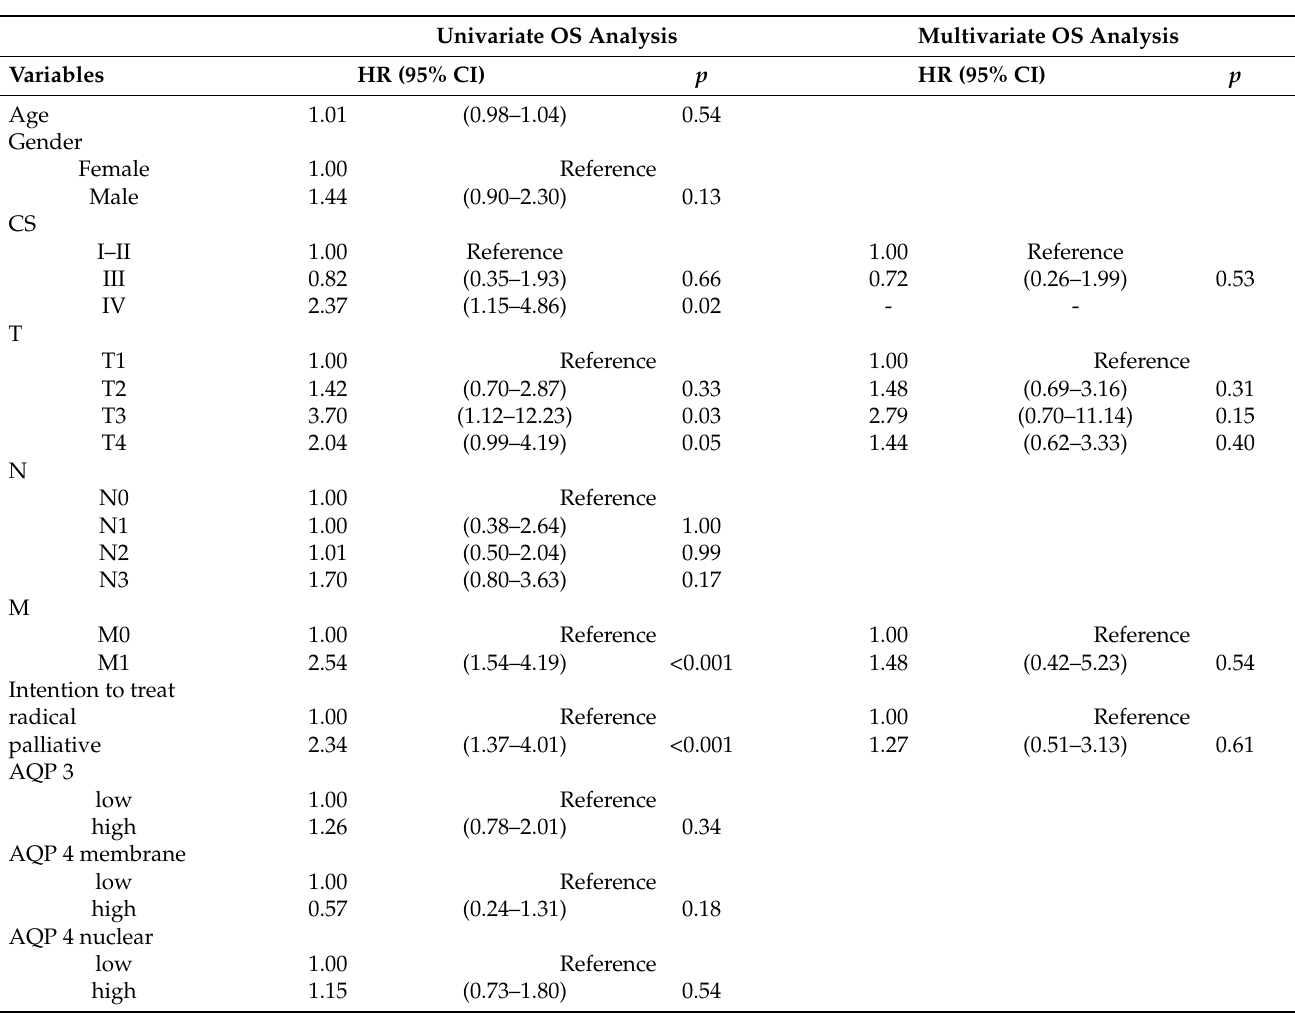
Table 3. Table shows the univariate and multivariate analyses for overall survival (OS) of all patients suffering from lung adenocarcinoma